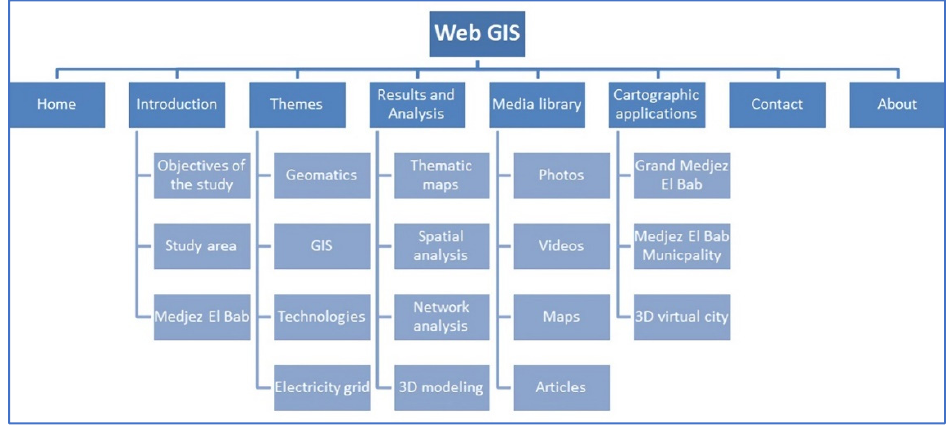
Figure 11. Website structuring.